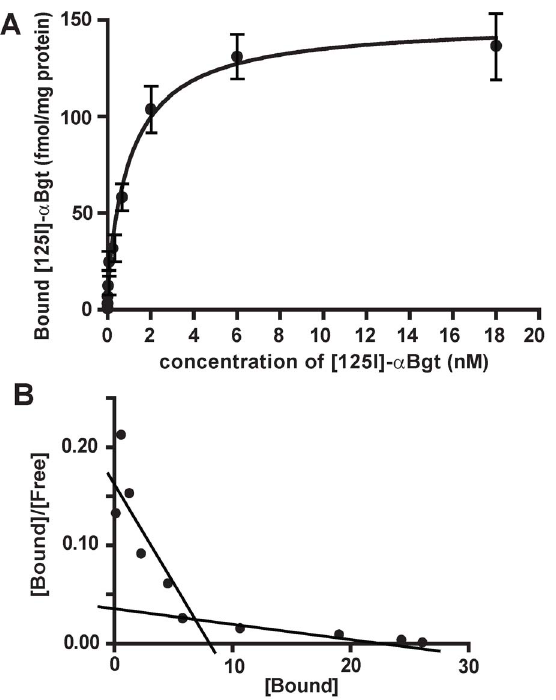
Figure 1. [ 125 I]- a -Bungarotoxin specific binding on pea aphid. Saturation curves (A) and Scatchard plots (B) for [ 125 I]- a -Bungarotoxin ( a -Bgt) specific binding. Membranes were extracted from whole parthenogenetic adults of pea aphid Acyrthosiphon pisum LSR1. Results are means of four experiments. Error bars represent the SEM.